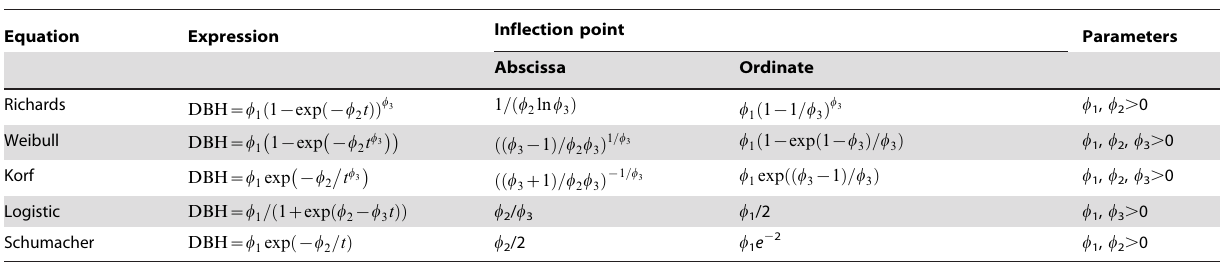
Table 2. Mathematical expressions of the five equations.